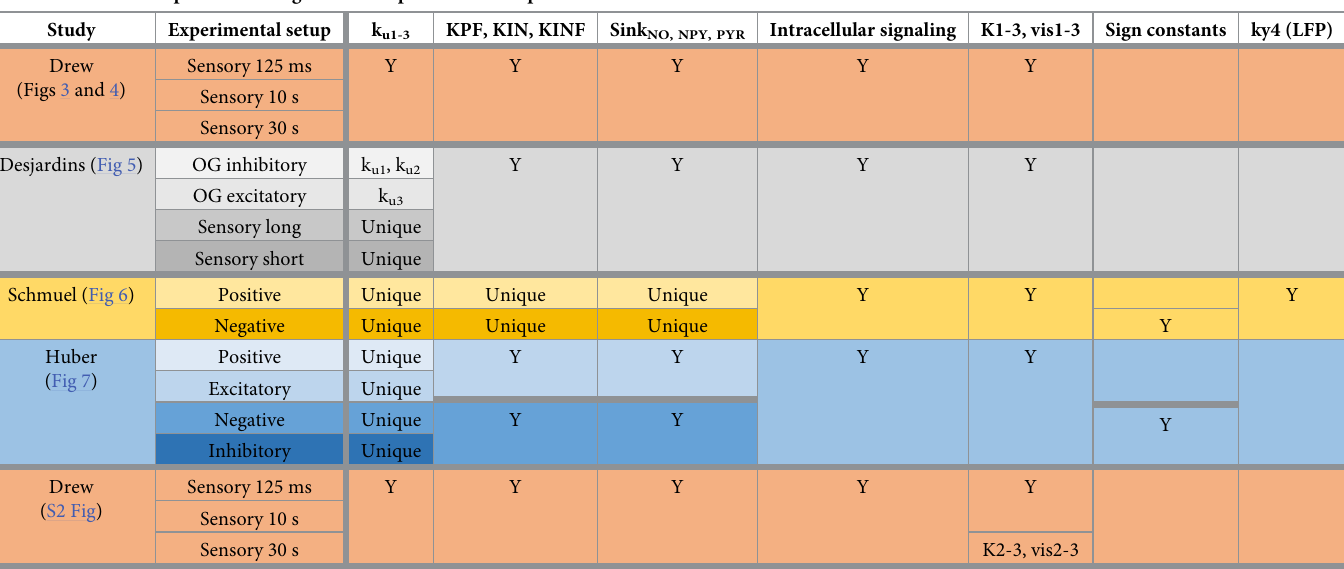
The columns clarify the different groups of parameters, k u1-3 –stimulus scaling parameters, KPF, KIN, and KINF–neuronal signaling parameters, Sink NO, NPY, PYR − elimination rate parameters, intracellular signaling parameters, K1-3, and vis1-3—viscoelasticity and stiffness coefficients, sign constants, and the LFP scaling parameter ky4. These groups of parameters are indicated where they are held the same over all experimental setups (rows) in a study and where they do differ. The studies are separated by a thicker line and by color. Within the studies, changes in parameters are indicated by altering color gradients within the color group and by notification explained below. Blank columns represent that the parameters are not included in the corresponding experimental setups. Y–the same over all experimental setups within the study; Unique–parameters unique to this experimental setup in the study;